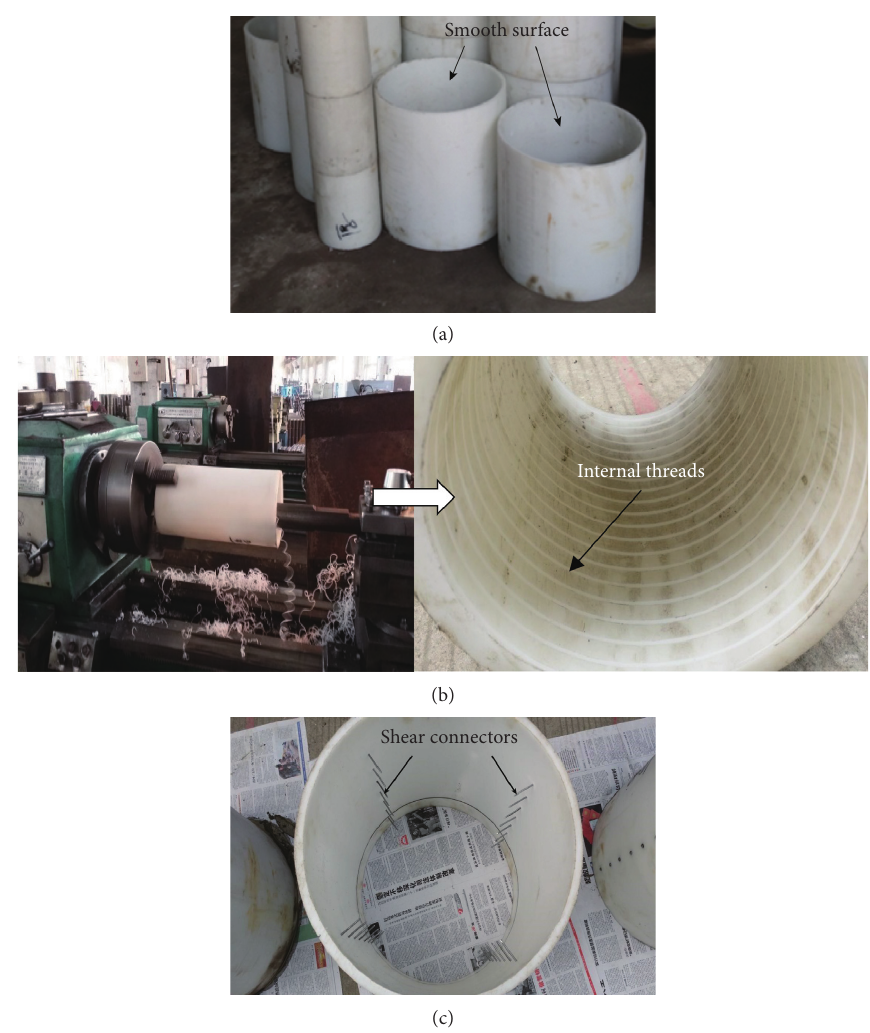
Figure 2: Different types of FRP tubes. (a) Normal FRP tubes. (b) FRP tube with internal threads. (c) FRP tube with shear